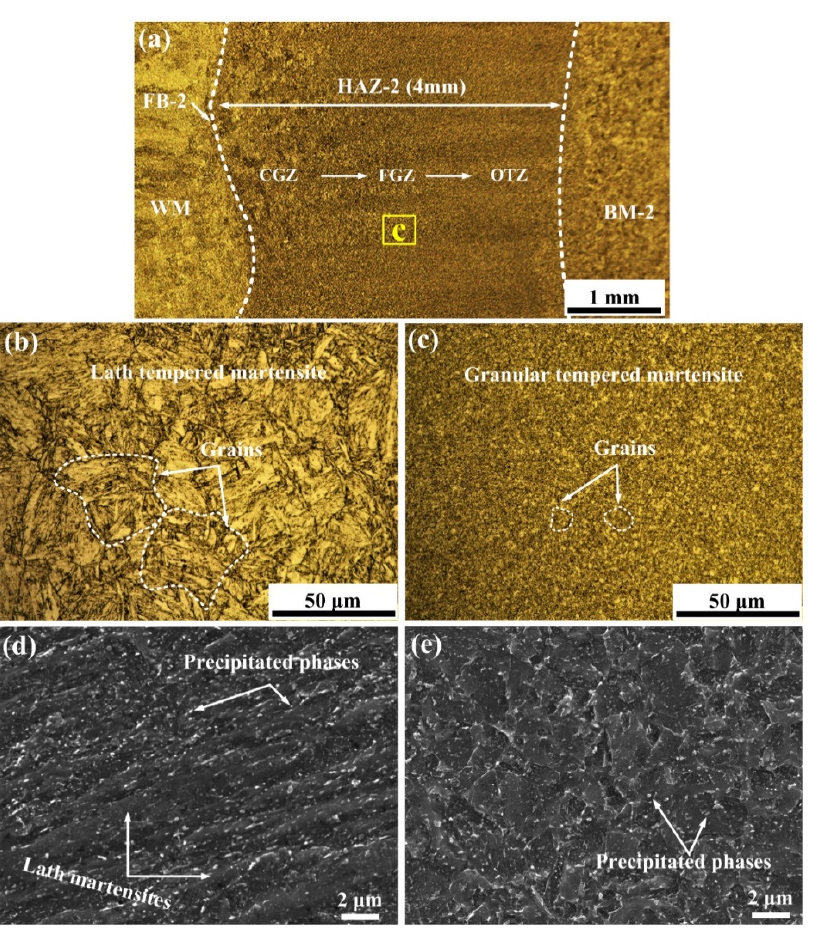
Figure 11. Microstructures of BM-2 and HAZ-2 obtained by OM and SEM. ( a ) Overall micrograph of HAZ-2. ( b ) OM micrograph of BM-2. ( c ) OM micrograph of FGZ in HAZ-2. ( d ) SEM micrograph of BM-2. ( e ) SEM micrograph of FGZ in HAZ-2.